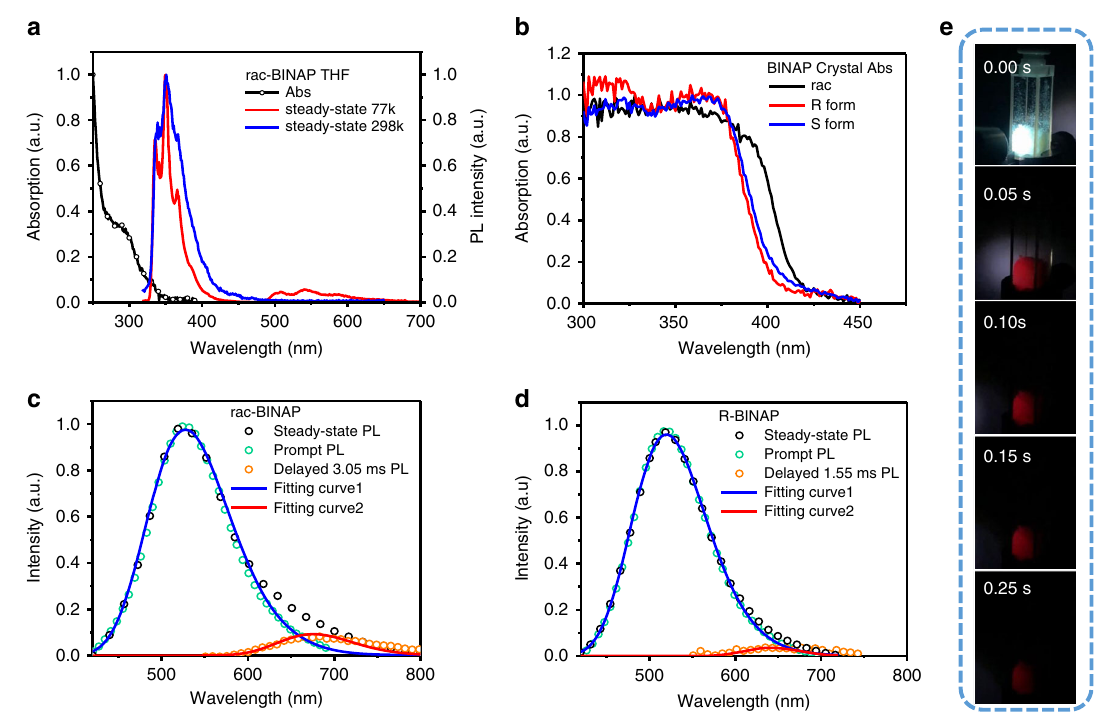
Fig. 2 Fundamentally photophysical properties of BINAP. a Absorption and emission of rac- BINAP in THF. b Absorption spectra of the crystal of BINAP in each form. c The emission of rac- BINAP and d R- BINAP in single crystals. Steady-state emission (black circle) were acquired by continuously 360-nm excitation. The prompt fl uorescence (cyan circle) were acquired by pulse excitation (360 nm), and detected by intensi fi ed charge-coupled detector (ICCD) opened at t = 0 with 50-ns gate width. The phosphorescence (orange circle) were detected by ICCD opened at t = 3.05 ms (rac- BINAP ) and t = 1.55 ms (R- BINAP ) with 200- μ s gate width. The fl uorescence (blue solid lines) and phosphorescence (red solid lines) spectra were deconvoluted from the steady- state emission with Gaussian function. e Photographs of rac- BINAP taken under 365-nm UV lamp and after removal of 365-nm UV to 0.25 s (Fig. 2e). On the other hand, the deconvolution of R- BINAP (Fig. 2d) and S- BINAP emission spectra (Supplementary Fig. 17a) also resolves a slightly blue-shifted 650-nm emission (cf.